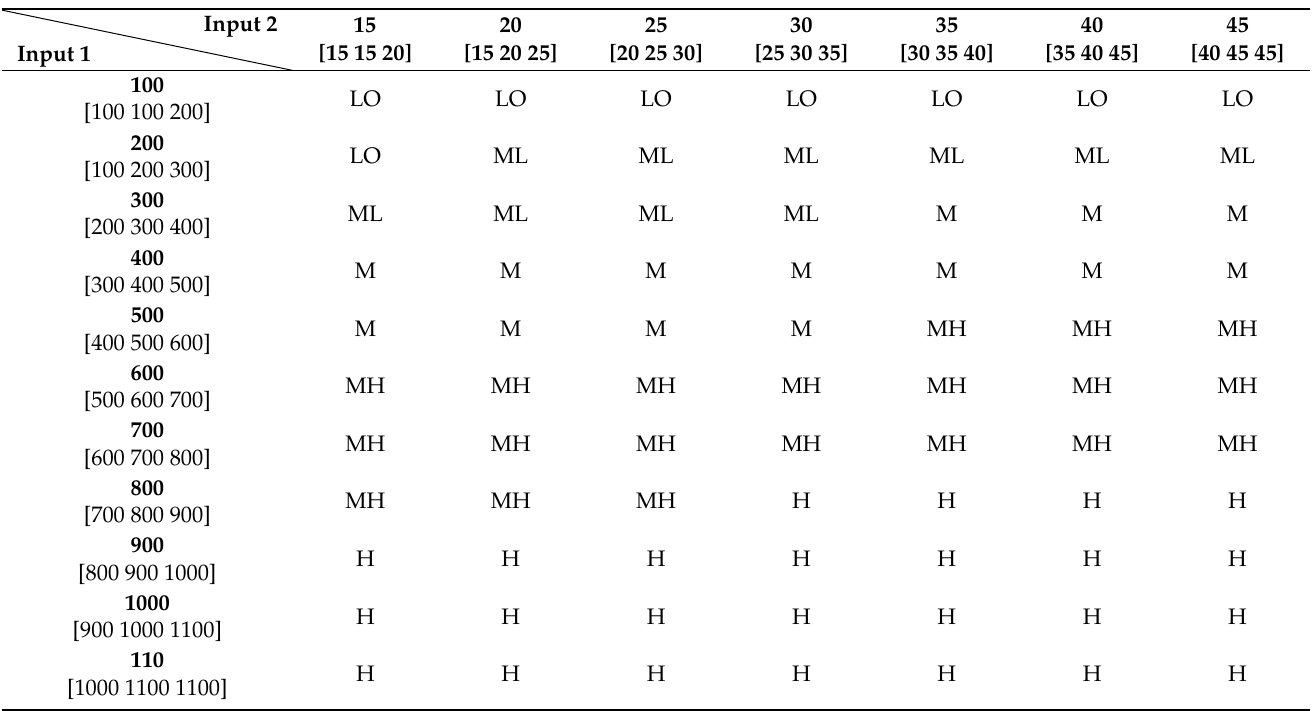
Table 4. Rule base matrix of a fuzzy